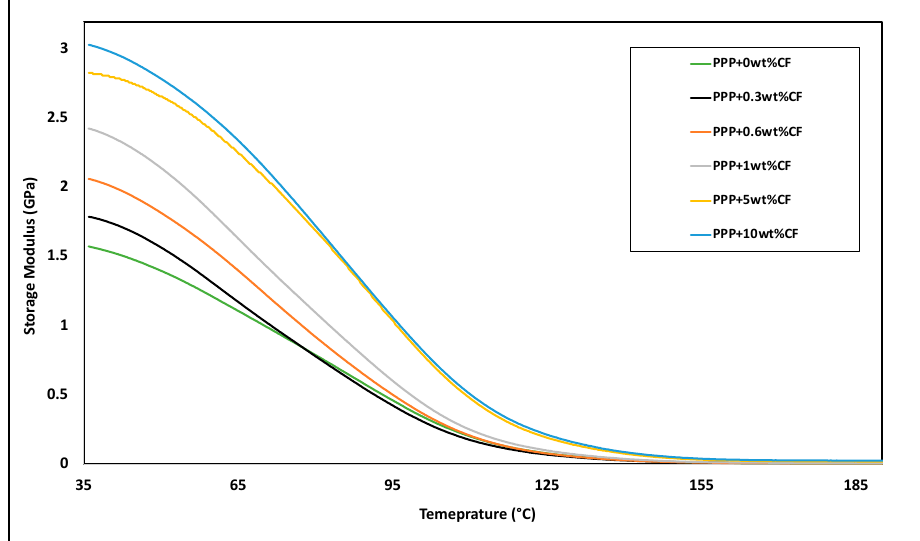
Figure 7. DMA test result of PPP/CF composites; effect of CF content in SLS-Printed fully cured thermosetting samples on storage modulus.